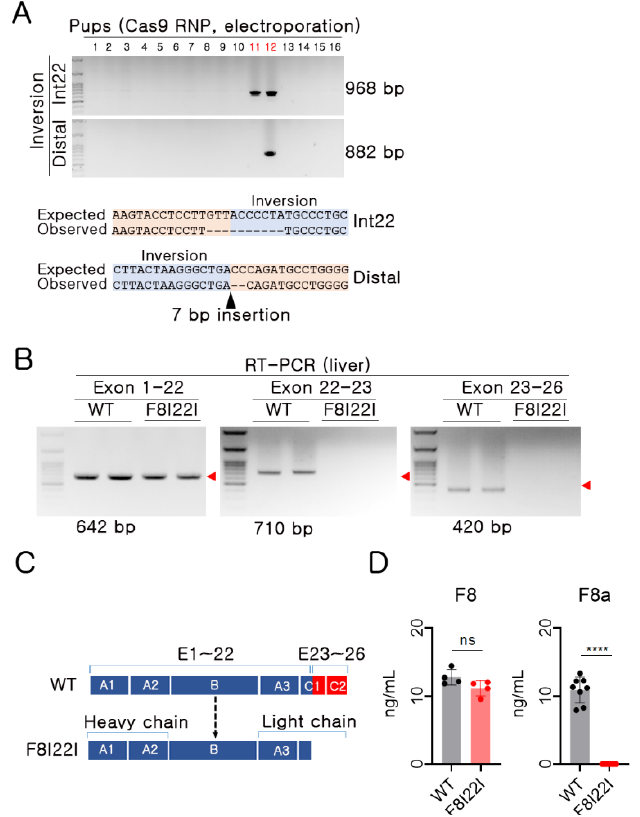
Figure 2. Generation of F8I22I mouse. ( A ) PCR and Sanger sequencing-based genotyping using gDNA. ( B ) RT-PCR for each mRNA fragment of exon 1–22, 22–23, and 23–26. Red symbol: target size. ( C ) Expected amino acid translation between wild type (WT) and F8I22I mouse. Blue box: preserved amino acids after inversion, Red box: missed amino acid after inversion. ( D ) Reactive protein of FVIII and FVIII activity was measured by ELISA and chromogenic analysis. Each dot indicates data from an individual mouse (FVIII ELISA, WT: n = 5, F8I22I: n = 5 and FVIII activity, WT: n = 8, F8I22I: n = 8) . Data are presented as mean ± SEM. ns : not significant, ****: p < 0.0001.